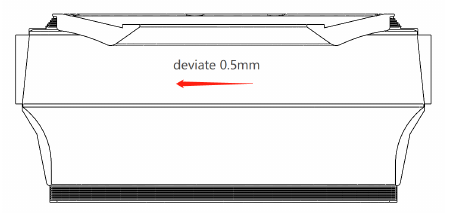
Figure 3. A 0.5 mm radial installation deviation model.